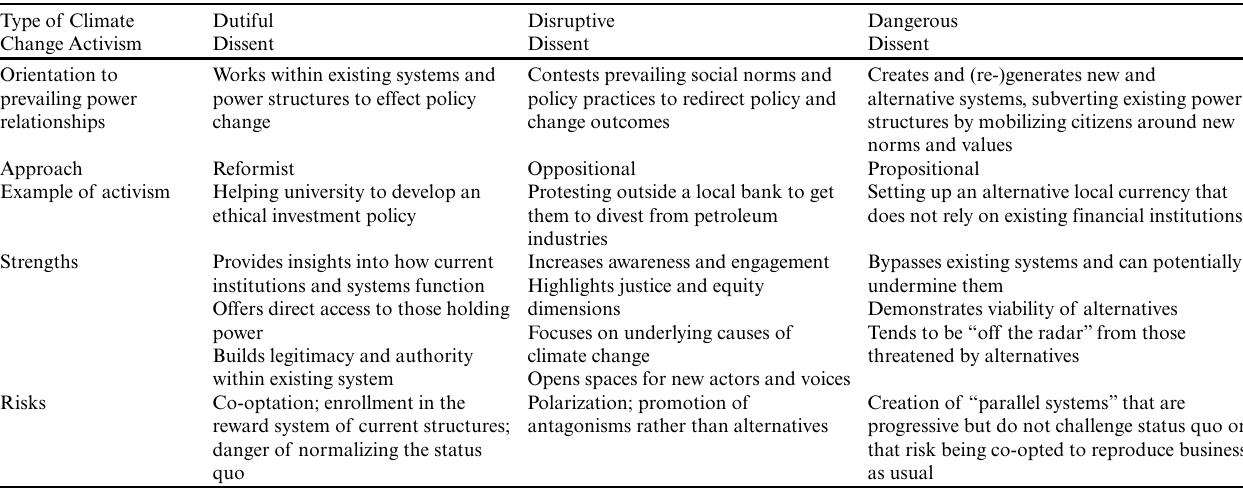
Table 1 . Summary of three types of dissent and their distinguishing